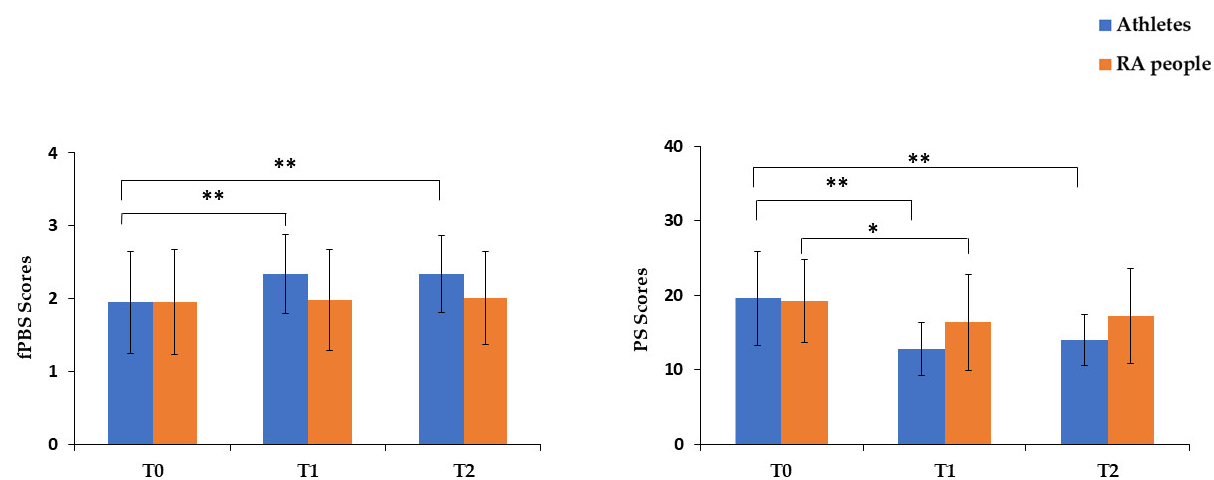
Figure 1. Time × Group interaction in functional psychobiosocial states (fPBS) and perceived stress (PS) in athletes and recreationally active (RA) people. Note: Error bars represent standard deviations. * p < 0.05; ** p < 0.001. Athletes’ fPBS: T0 vs. T1 Cohen’s d = 0.62; T0 vs. T2 Cohen’s d = 0.63. Athletes’ PS: T0 vs. T1 Cohen’s d > 1; T0 vs. T2 Cohen’s d > 1. RA people’ PS: T0 vs. T1 Cohen’s d = 0.46.